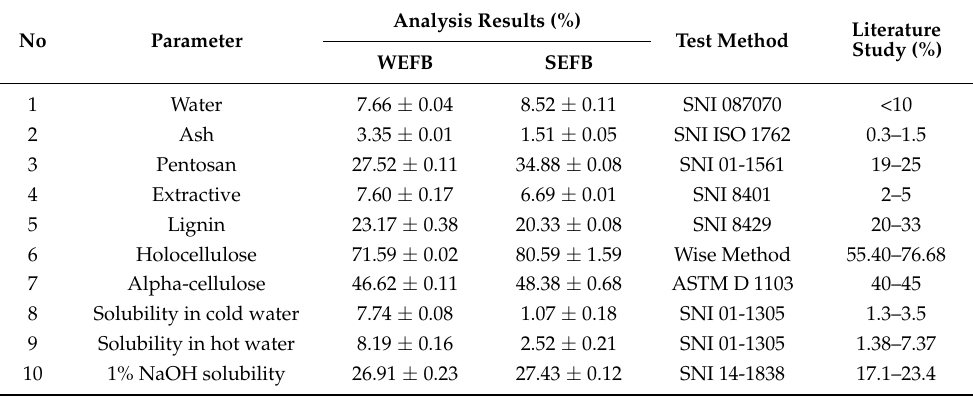
Table 4. Chemical characteristics of whole-empty fruit bunches (WEFB) and stalk-empty fruit bunches (SEFB).